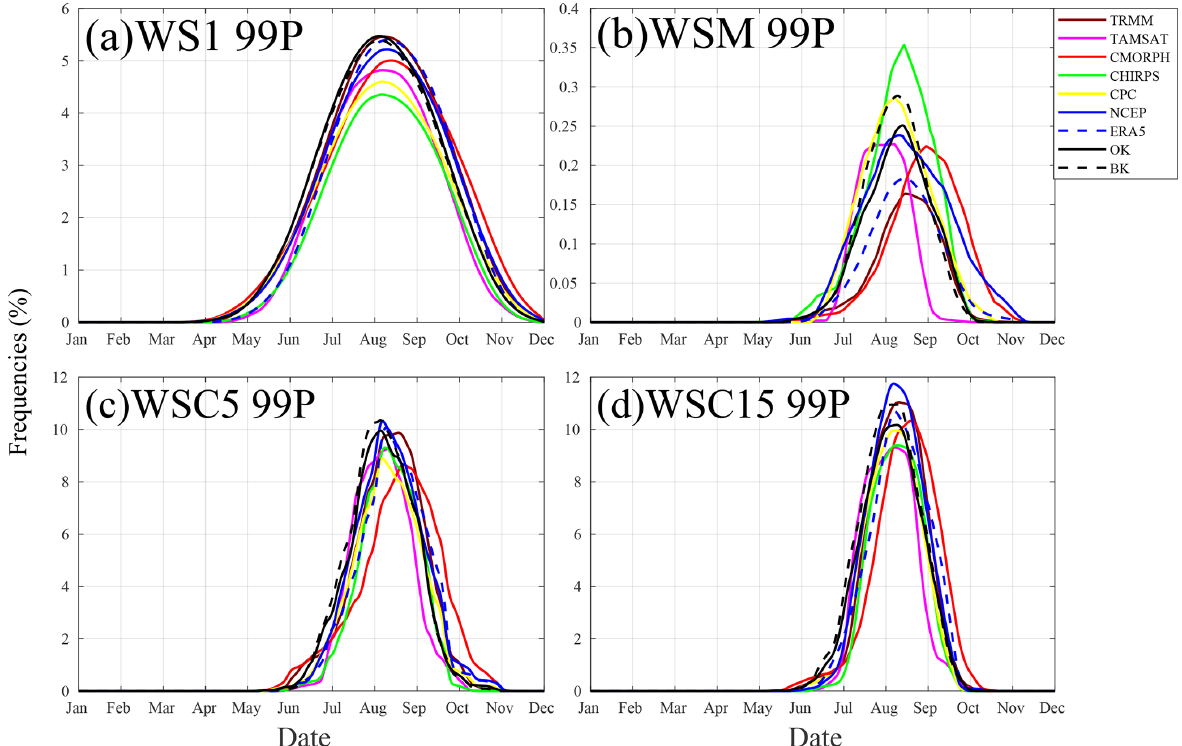
Figure 11. Seasonal cycle of four categories of wet spells, WS1, WSM, WSC5, and WSC15 (99th percentile), used in this study computed for the overlap between datasets (1998–2010): TRMM, TAMSAT, CMORPH, CHIRPS, CPC, NCEP, ERA5, BK, and OK. Frequency is defined as a ratio of observational days with recorded wet spells. Details on the datasets and wet spells are provided in Tables 1 and 3, respectively.